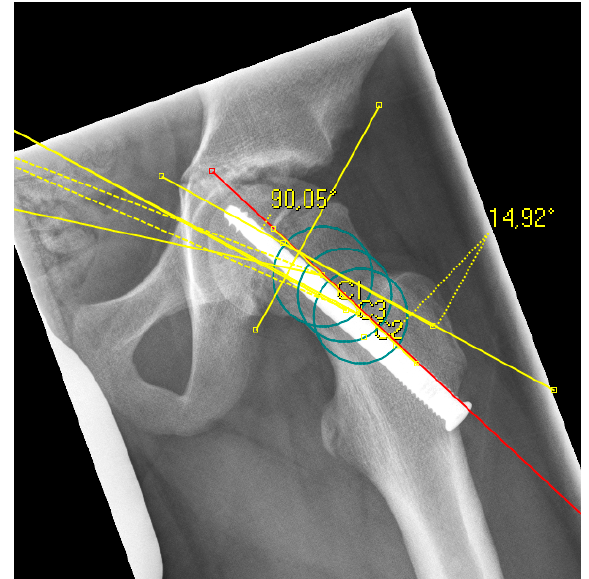
Figure 2. Example of a radiograph with the measurement of the epiphyseal tilt based on the anatomical femoral neck axis (red line), which was determined with three circles (green) according to Bouma [29].